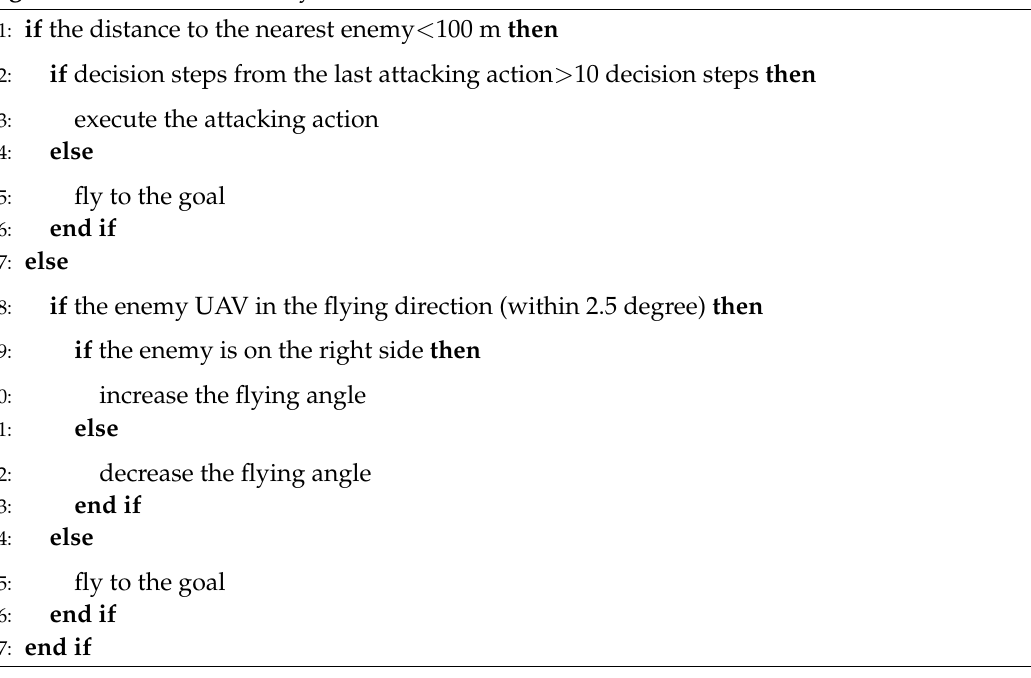
Algorithm 2 Fixed-rule